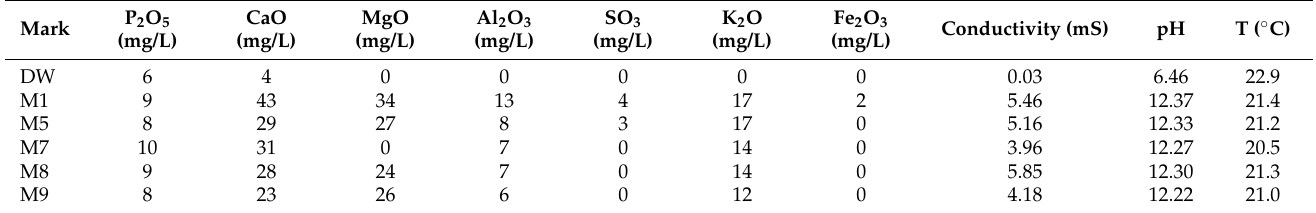
Table 6. Amounts of oxides leached from the samples and properties of leachate (DW—distilled